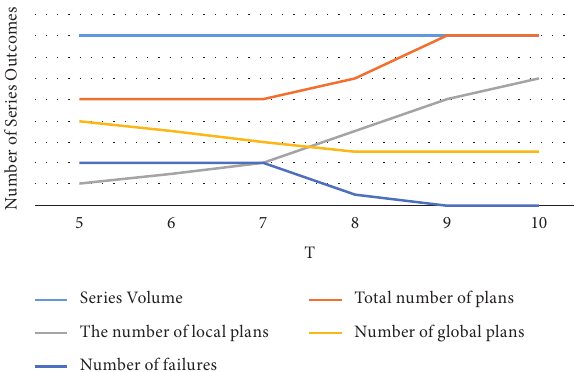
Figure 7: Implementations of evolutionary network processes depending on the module of connections ( T ).